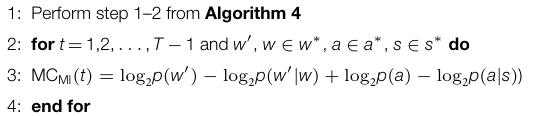
ALGORITHM 5 | Algorithm for state-dependent MC MI ( t )